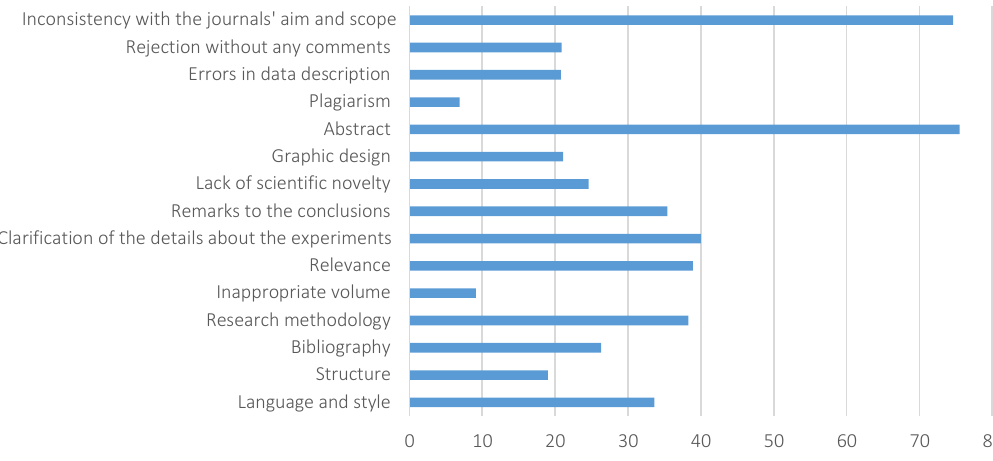
Figure 9. Reviewers’ comments in the case of a negative review